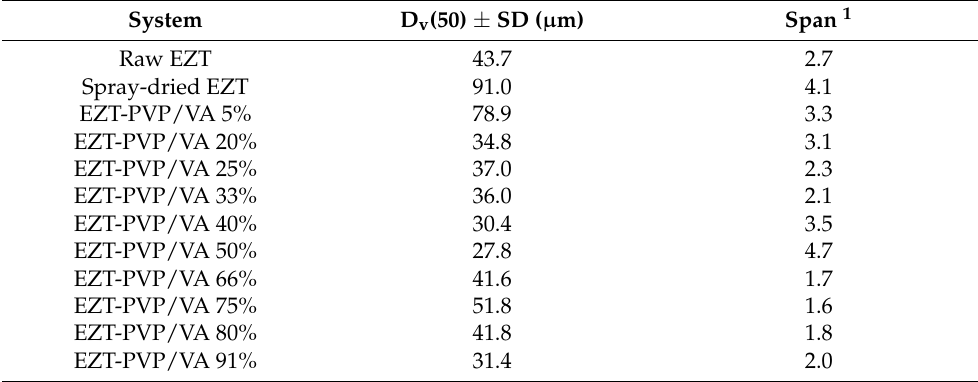
Table 1. Particle size of solid dispersions obtained using the laser diffraction method.